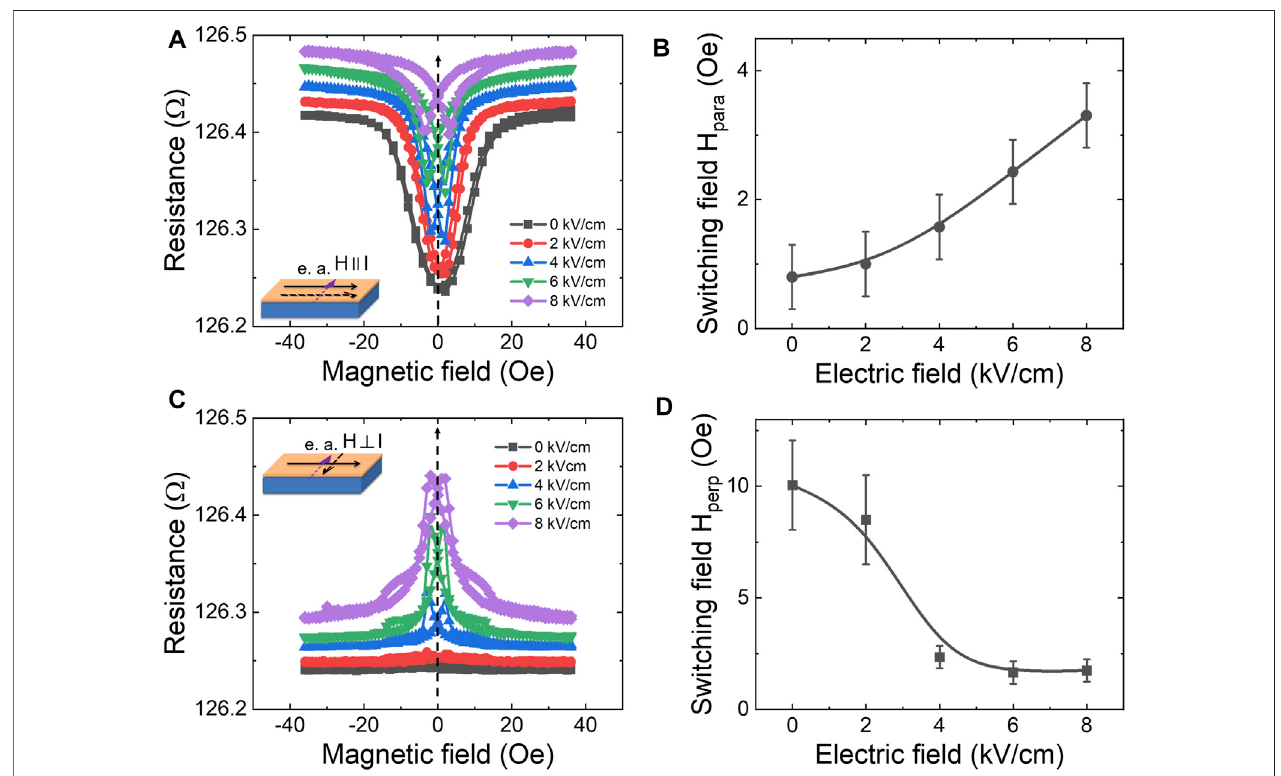
FIGURE 2 | (A) and (C) Magnetoresistance in the Conetic alloy thin fi lm/PMN – PT multiferroic heterostructure as a function of the applied magnetic fi eld with different bias E- fi elds. Magnetic fi eld H (black dotted line) is parallel and perpendicular to current I (black solid line) in the inset of Panels (A,C) , respectively. (B) and (D) Dependence of the switching fi eld on the E- fi elds in the Conetic alloy thin fi lm/PMN – PT multiferroic heterostructure when the magnetic fi elds are along [01 1] and [100] directions of the FE layer, respectively.